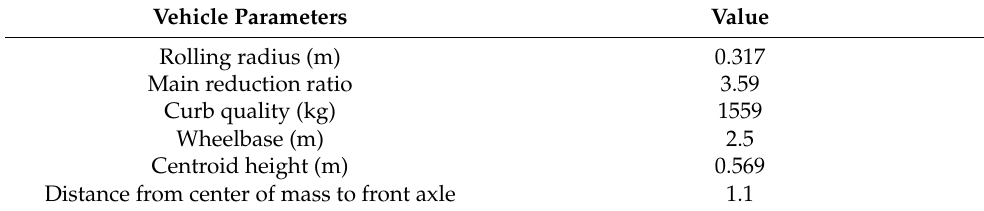
Table 3. Important vehicle parameters for simulation.